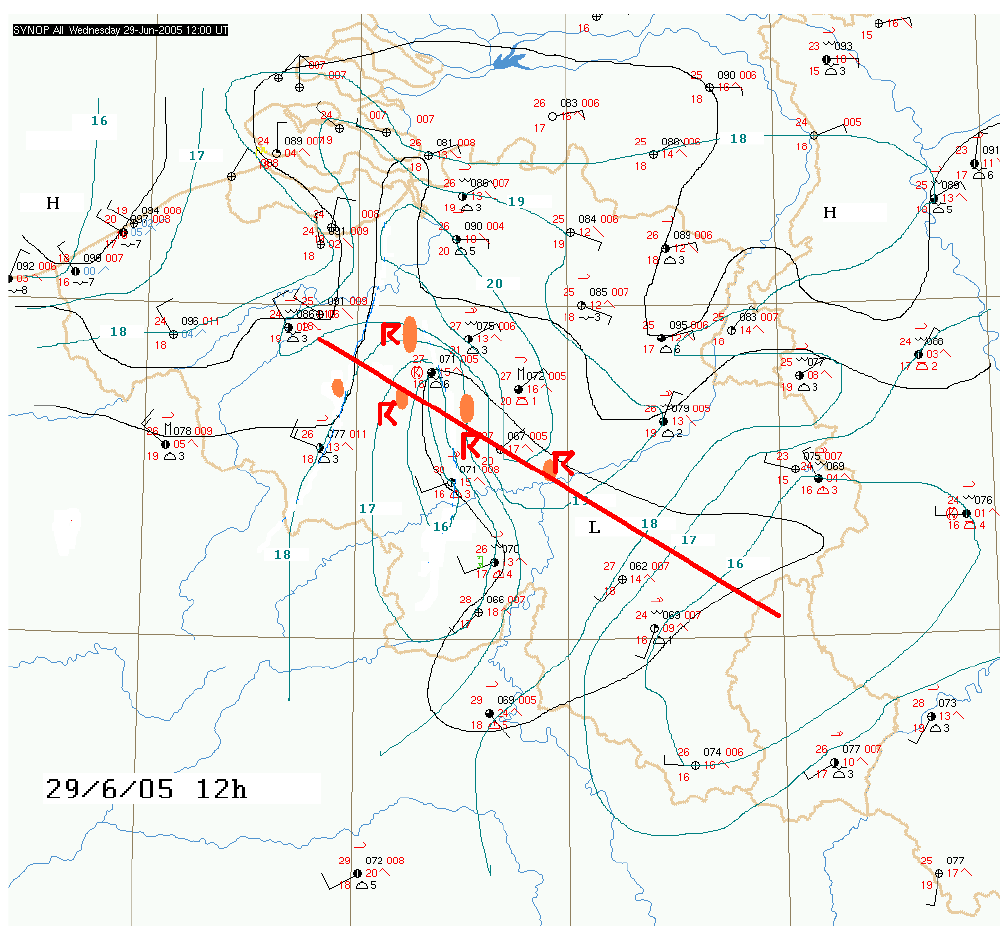
Figure 3. Meso-scale surface analysis based only on observations. Plot of the major line of convergence is shown in red, radar precipitation in orange, thunderstorms detected by SAFIR in R-shape red symbols, contours of the dew point temperature in green, and contours of the mean sea level pressure in black. The synoptic observations are indicated on the chart (temperature and dew point in red, wind flag and the mean sea level pressure in